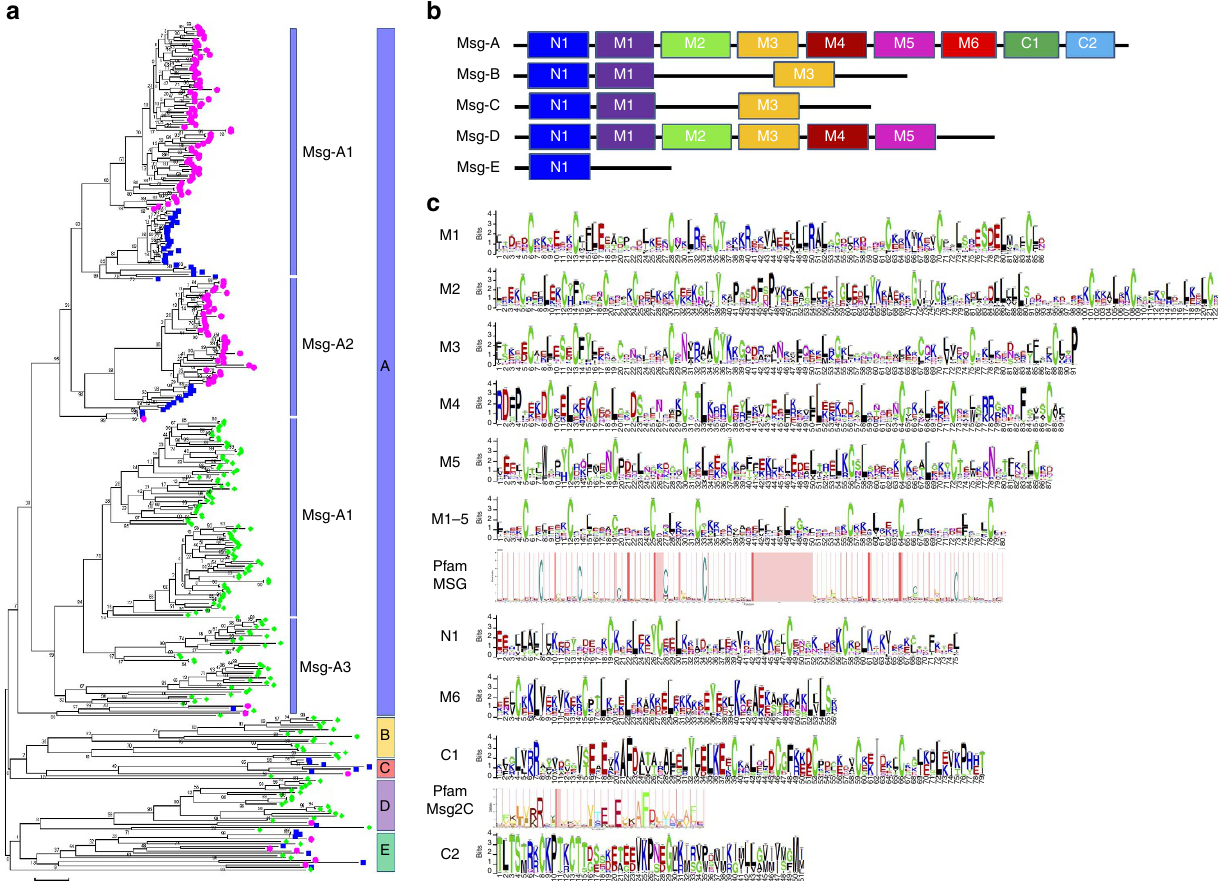
Figure 3 | The Msg superfamily in three Pneumocystis species. ( a ) Phylogeny of 384 Msg proteins identified in P. murina (blue squares), P. carinii (pink circles) and P. jirovecii (green diamonds). They are classified into five families of Msg-A, -B, -C, -D and -E, as indicated by the vertical bars on the right side. The Msg-A family is further classified into three subfamilies of Msg-A1 (classical Msg genes), Msg-A2 (Msr genes) and Msg-A3 (other Msg-associated genes). ( b ) Schematic representations of conserved domains in five Msg families. ( c ) Sequence logos showing the frequency of amino acid composition in Msg domains. Previously identified Pfam MSG and Pfam Msg2_C domains are included for comparison. Additional information on the Msg domain analysis is provided in Supplementary Note